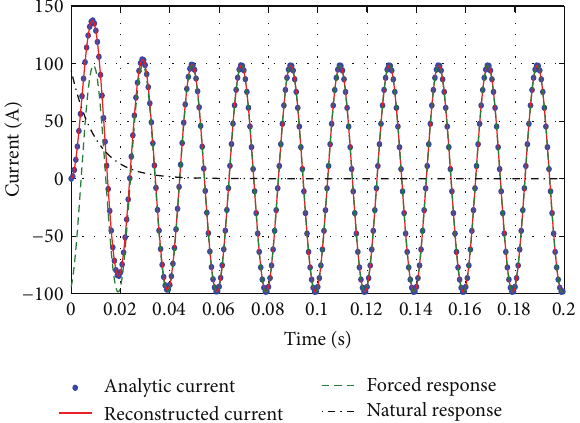
Figure 2: The analytic and reconstructed currents of the series RL circuit along with its forced and natural responses.